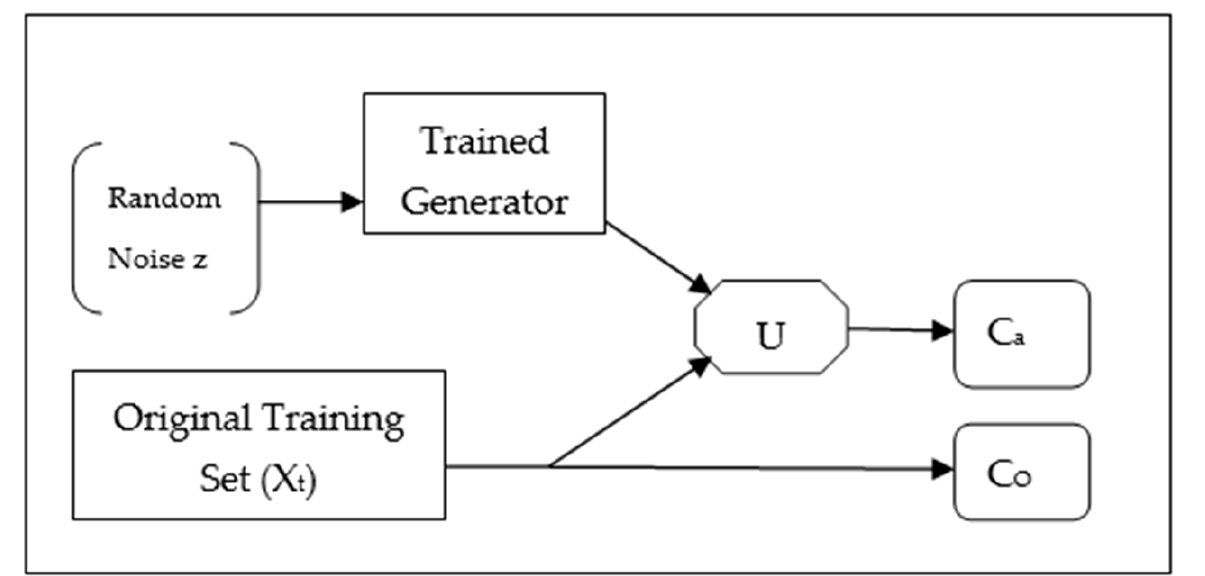
Figure 9. The G* is fed with z (random noise) and the output is merged with x t . Other than that, the classifier C is trained on original and augmented training sets (C O and C a ).